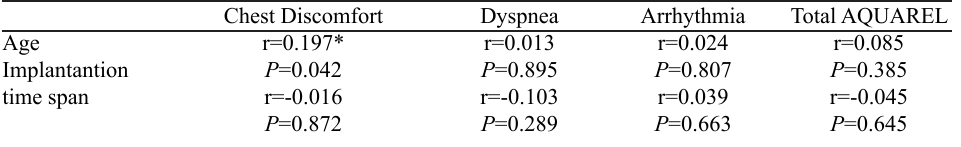
Table 4. Pearson correlation coefficient and P value between score values of AQUAREL questionnaire domains and age and implantation time span.